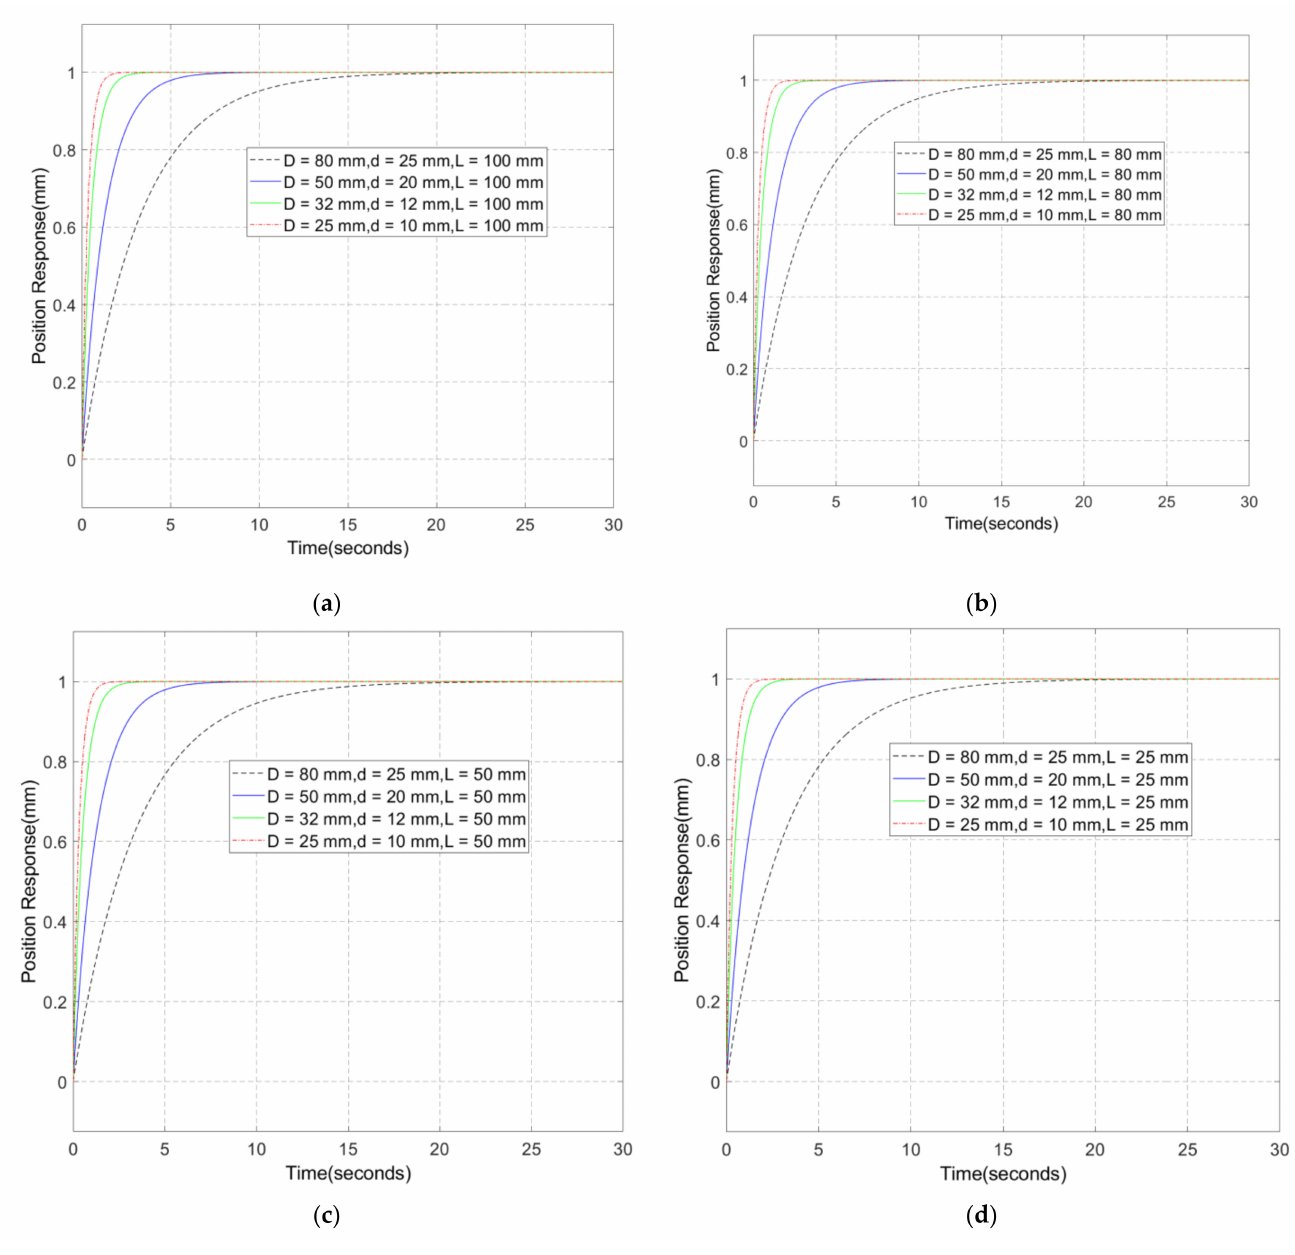
Figure 8. Output response curves of cylinder positions with different cylinder diameters. ( a ) L = 100 mm; ( b ) L = 80 mm; ( c ) L = 50 mm; ( d ) L = 25